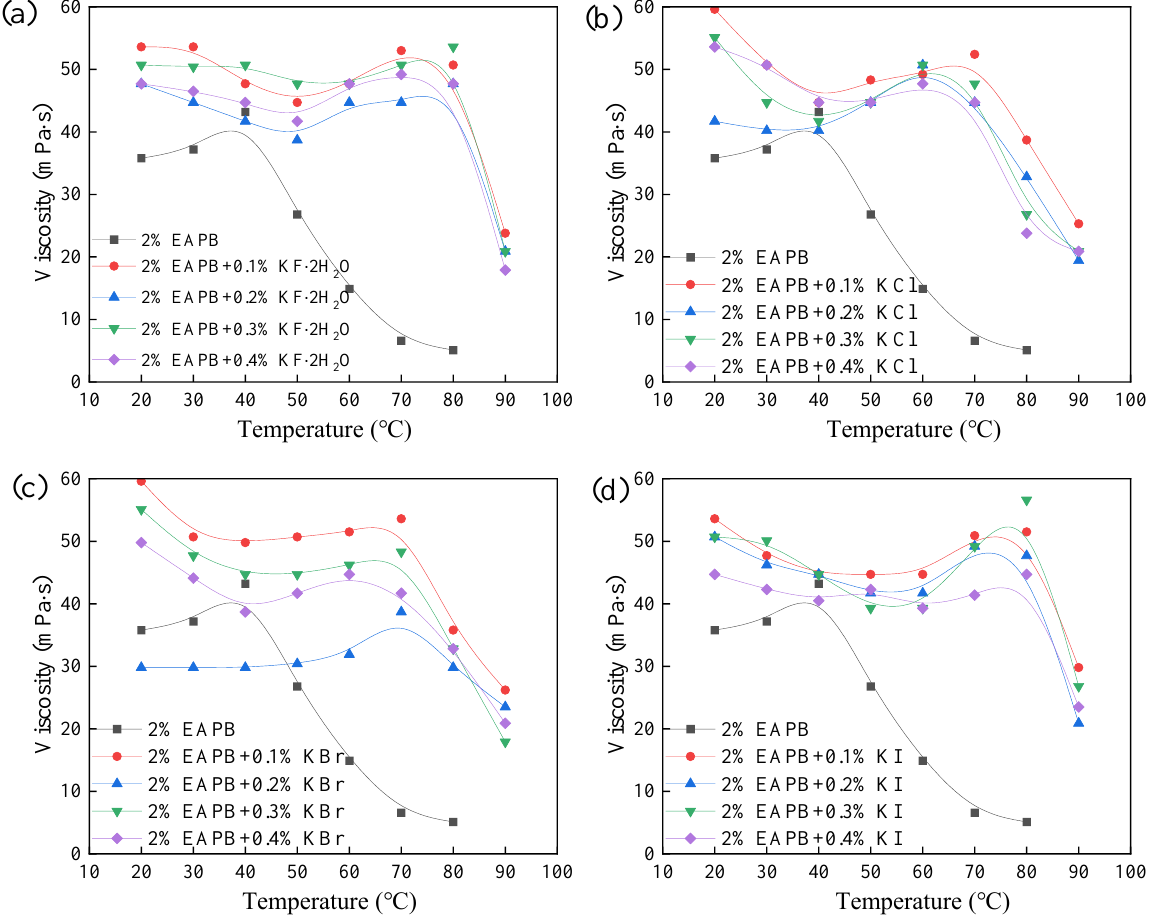
Figure 6. Effect of different potassium salt concentrations on viscosity ( a ) KF; ( b ) KCl; ( c ) KBr and ( d ) KI. (100 r min −1 ).